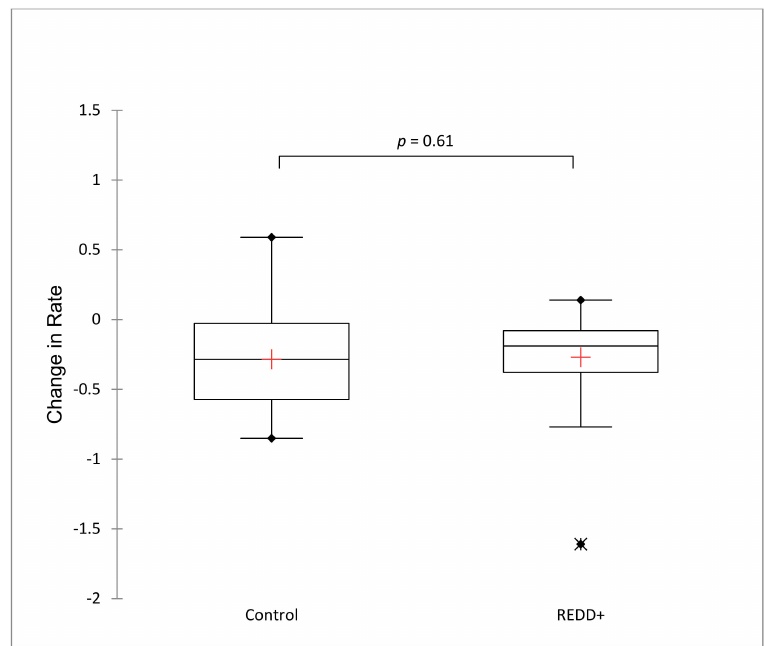
Figure 3. Boxplots and Mann–Whitney U two-sample comparison of change in the annual rate of forest cover loss after REDD + implementation (2010–2018) in matched control municipalities derived from propensity score matching (0) and treated or REDD + intervened municipalities